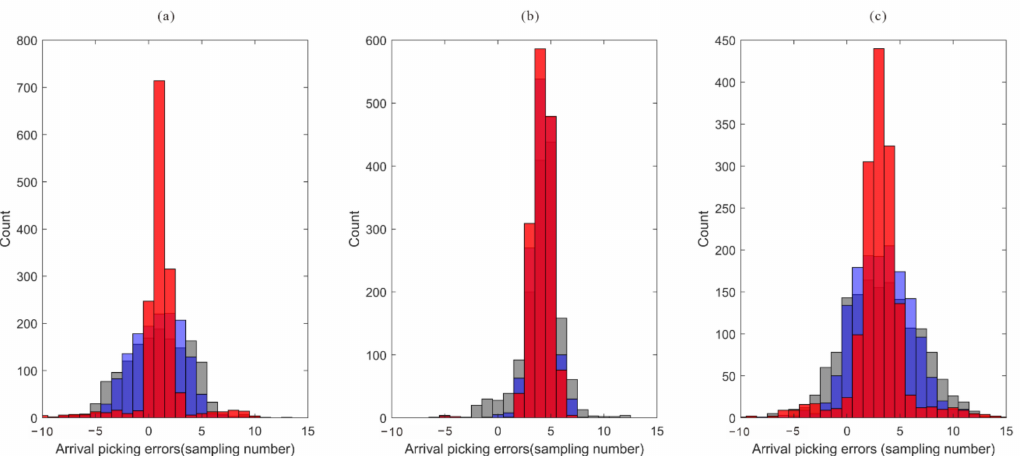
Figure 7. The stacked waveforms of each event obtained by different arrival picks. ( a , b ) are the P and S-wave stacked waveform using arrivals from STA/LTA; ( c , d ) are the P and S-wave stacked waveform using arrivals from intra-event optimization processing; ( e , f ) are the P and S-wave stacked waveform using arrivals from global optimization processing. The horizontal gray line represents the location of arrivals, and the recordings are processed by energy balancing between traces for better visibility.